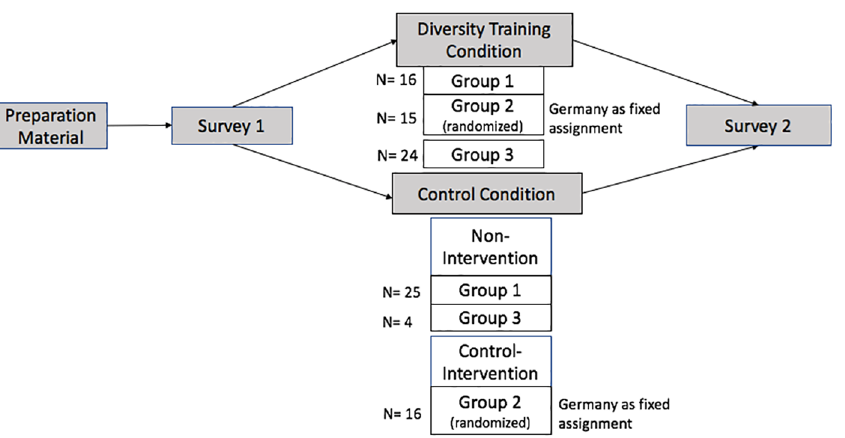
Figure 1. Illustration of research